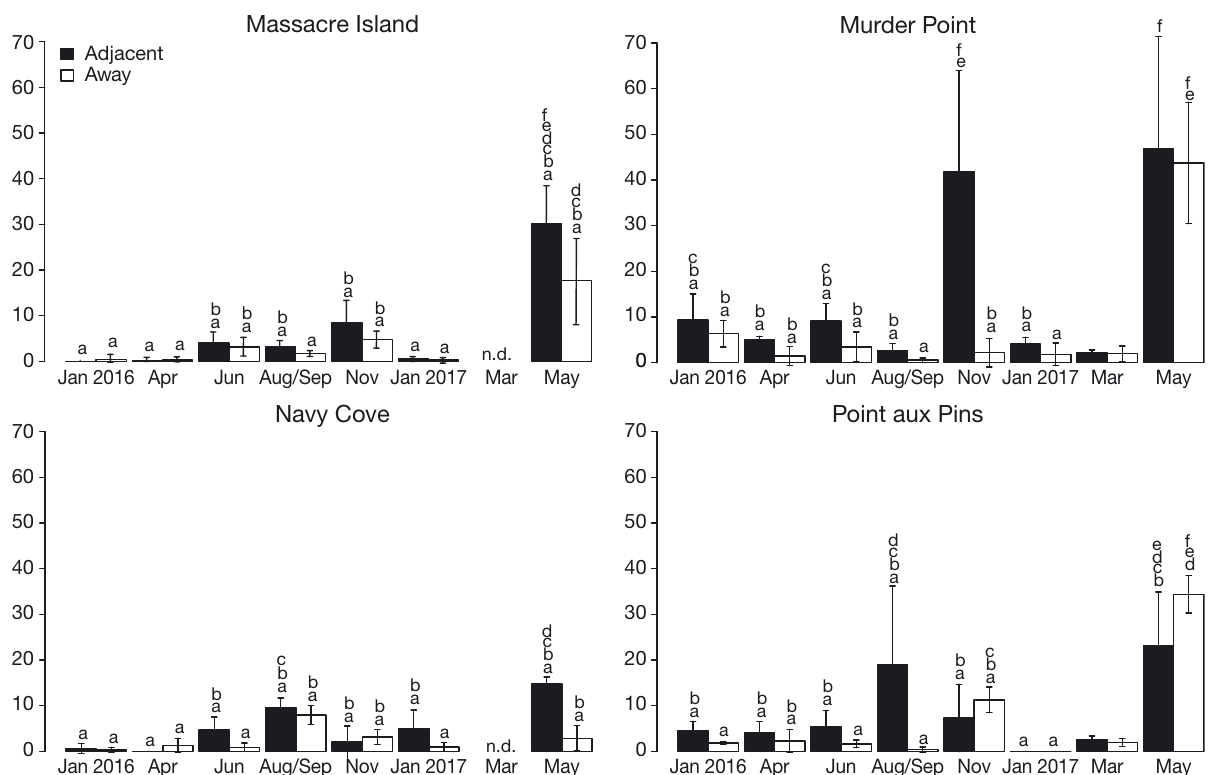
Fig. 5. Mean (±SD) spionid polychaete larvae abundance (n = 3) for the collection date × oyster farm location × proximity to farm interaction. Letters indicate significant differences (Tukey post hoc test, p < 0.05); lettered differences do not include March 2017, but a 2-way ANOVA for that sampling date showed no significant